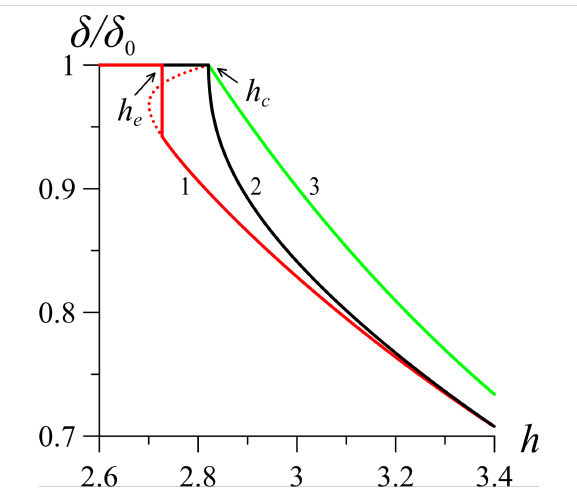
Figure 7: Dependence of the optical phase lag of the suspension on the applied magnetic field h for γ = 0.2 and σ = 5: curve 1 – κ = 0.01; curve 2 – κ = κ * = 0.056; curve 3 – κ = 0.5. Here h c = 2.824, h e =